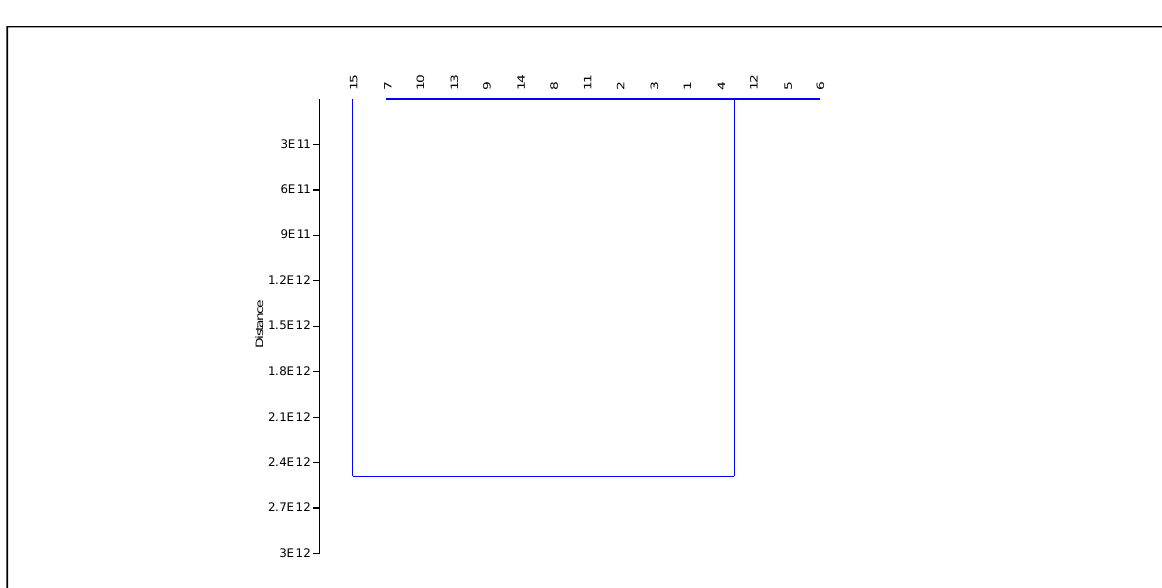
Figure 6: Dendrogram representing expression profiles that shows the relationship of CarE genes observed in both susceptible and resistant strains in Z. variegatus using LmcesE9 primers measured by qPCR